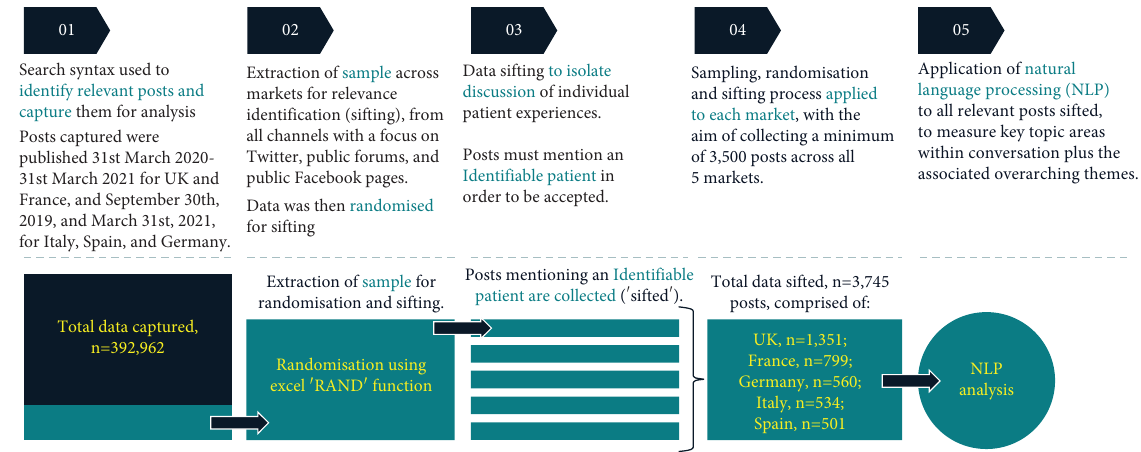
Figure 1: Overview of data sifting process for natural language processing